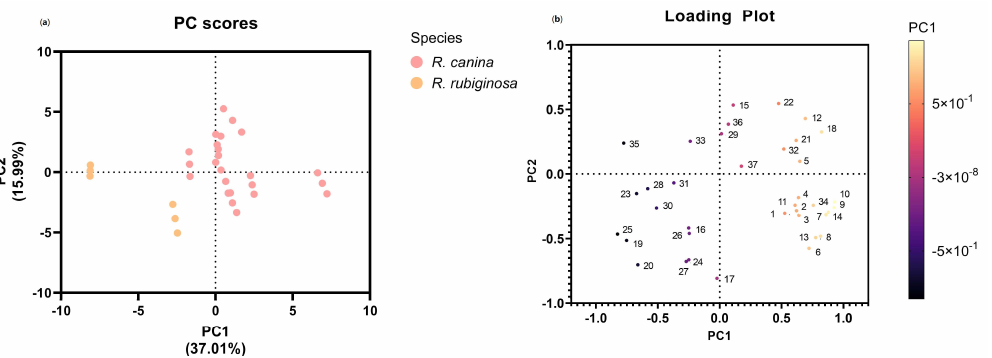
Figure 3. Principal component analysis (PCA) results: ( a ) the score plot generated by the two principal components indicating the difference between species; ( b ) the loading plot showing the variables that contribute to each one of the two principal components. The nomenclature of the varibles are as follows: (1) total phenolic content; (2) TEAC; (3) DPPH; (4) CUPRAC; (5) hy- droxycinnamic acid 1; (6) flavonol 1; (7) flavonol 2; (8) flavonol 3; (9) flavonol 4; (10) flavonol 6; (11) flavonol 7; (12) anthocyanin 1; (13) total flavonoid content; (14) catechin; (15) total anthocyanins;